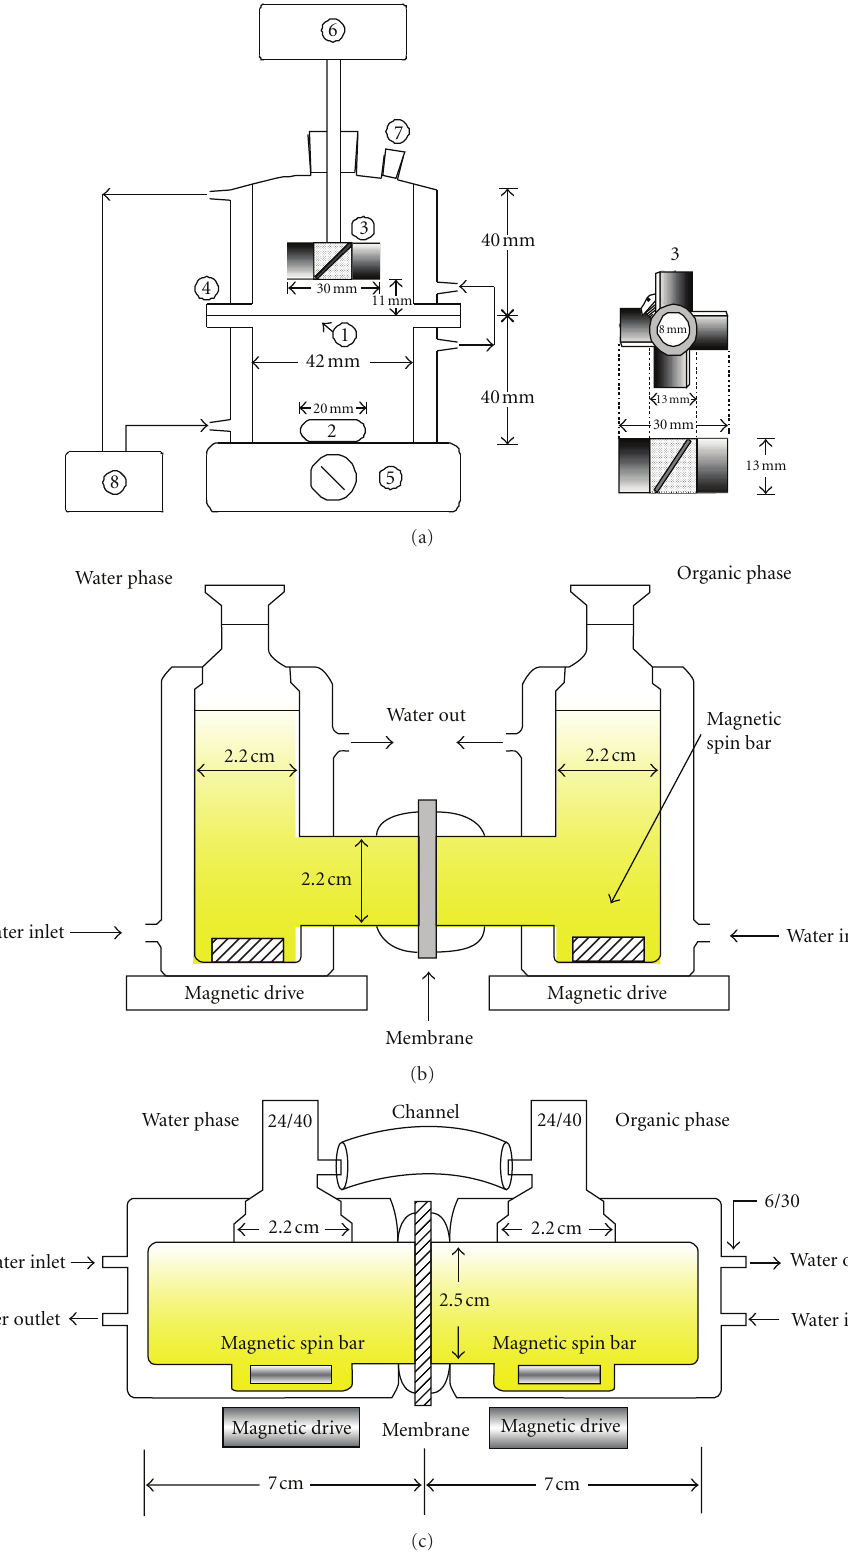
Figure 2: Schematic of (a) membrane reactor V1: membrane, 2; Teflon stir bar, 3; stainless stirrer, 4; membrane reactor, 5; magnetic stirrer, 6; mechanical stirrer, 7; sampling point, 8; cooling circulator bath [12]. (b) Membrane reactor H1. (c) Membrane reactor